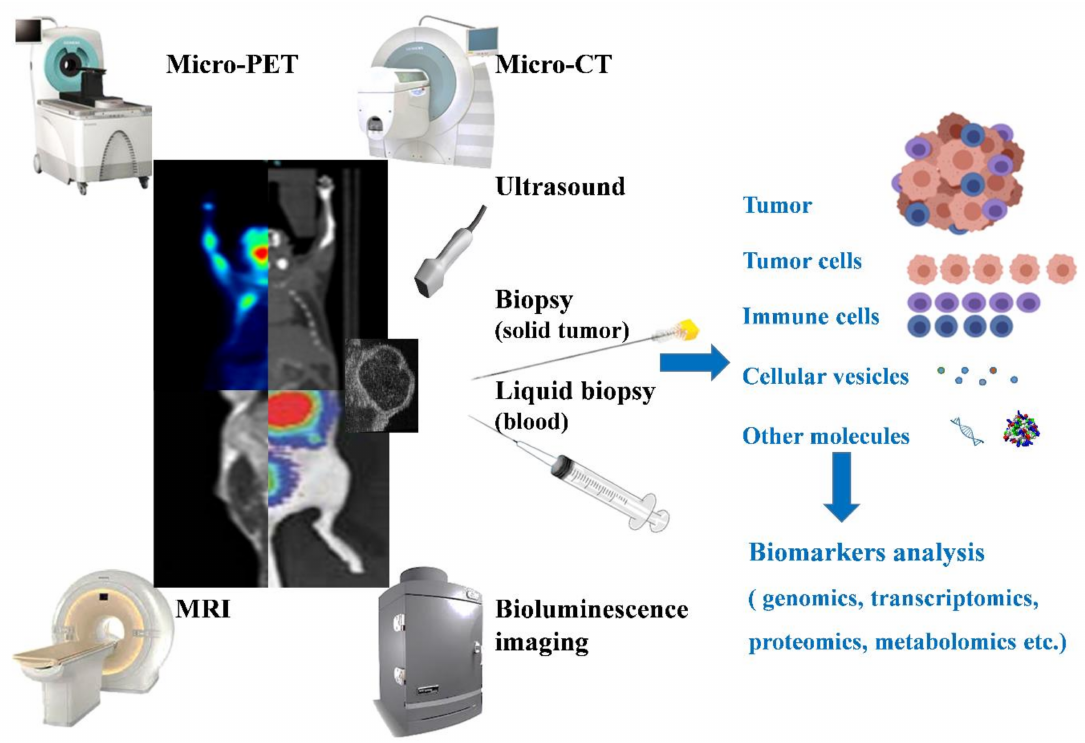
Figure 2. Equipment or methods used for in vivo tumor monitoring. Micro-PET, Micro-CT, MRI, ultrasound,